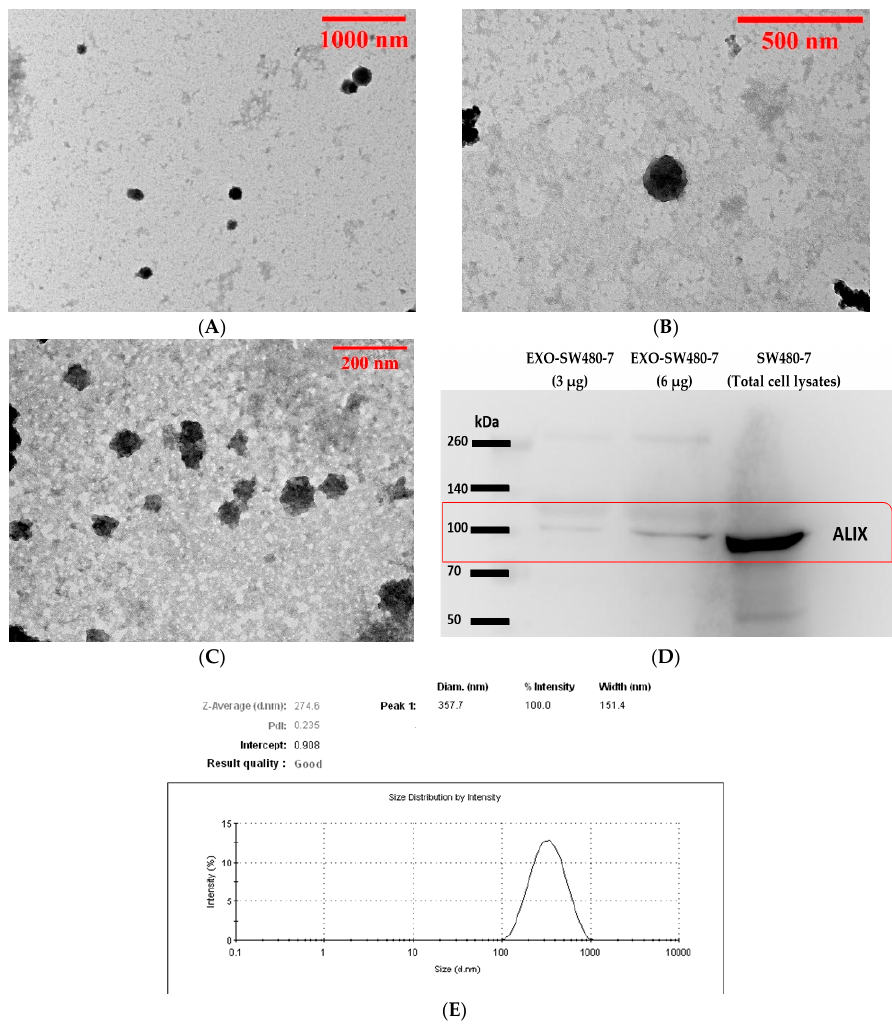
Figure 1. Characterization of exosomes. ( A , B ) Morphology of serum exosomes by transmission electron microscopy (TEM). ( C ) Morphology of exosomes derived from SW480-7. ( D ) Western blot analysis of exosomal protein PDCD6IP/ALIX derived from SW480-7. ( E ) The particle size distribution of exosomes derived from SW480-7 cell line. Table 2. Clinical and pathological characteristics of colorectal cancer (CRC) patients included in the present